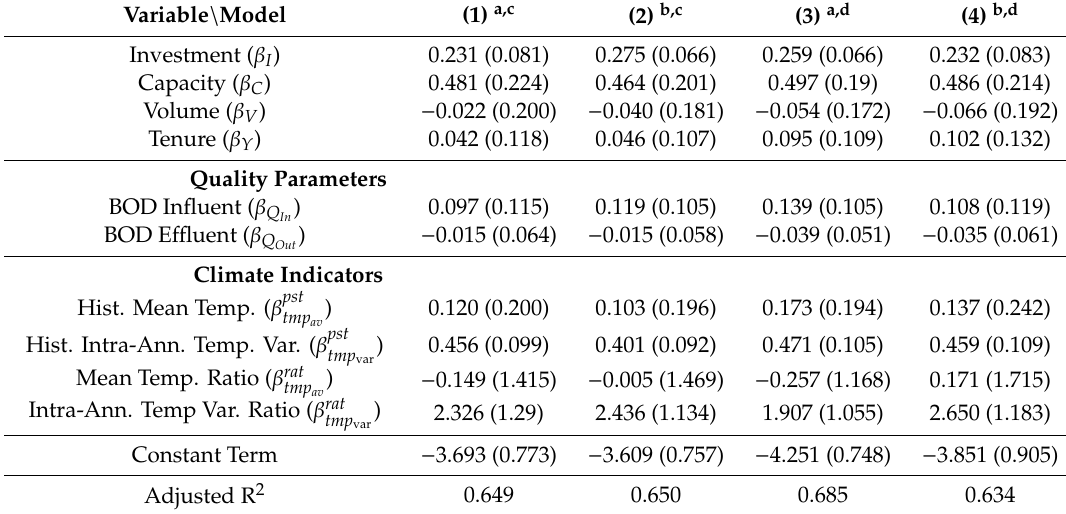
Table A2. Cost function estimation results using di ff erent sampling